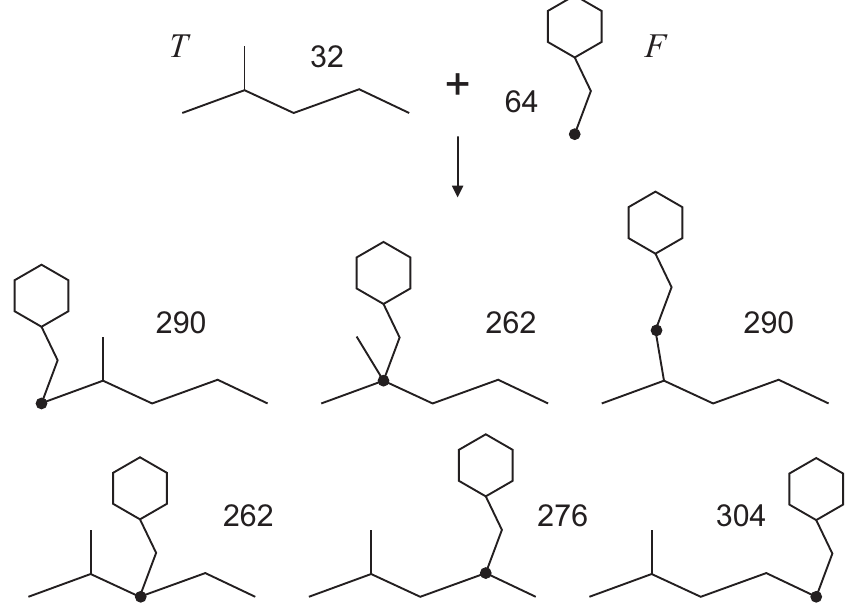
Figure 2: Family V of unicyclic graphs with W ( V ) = 1684